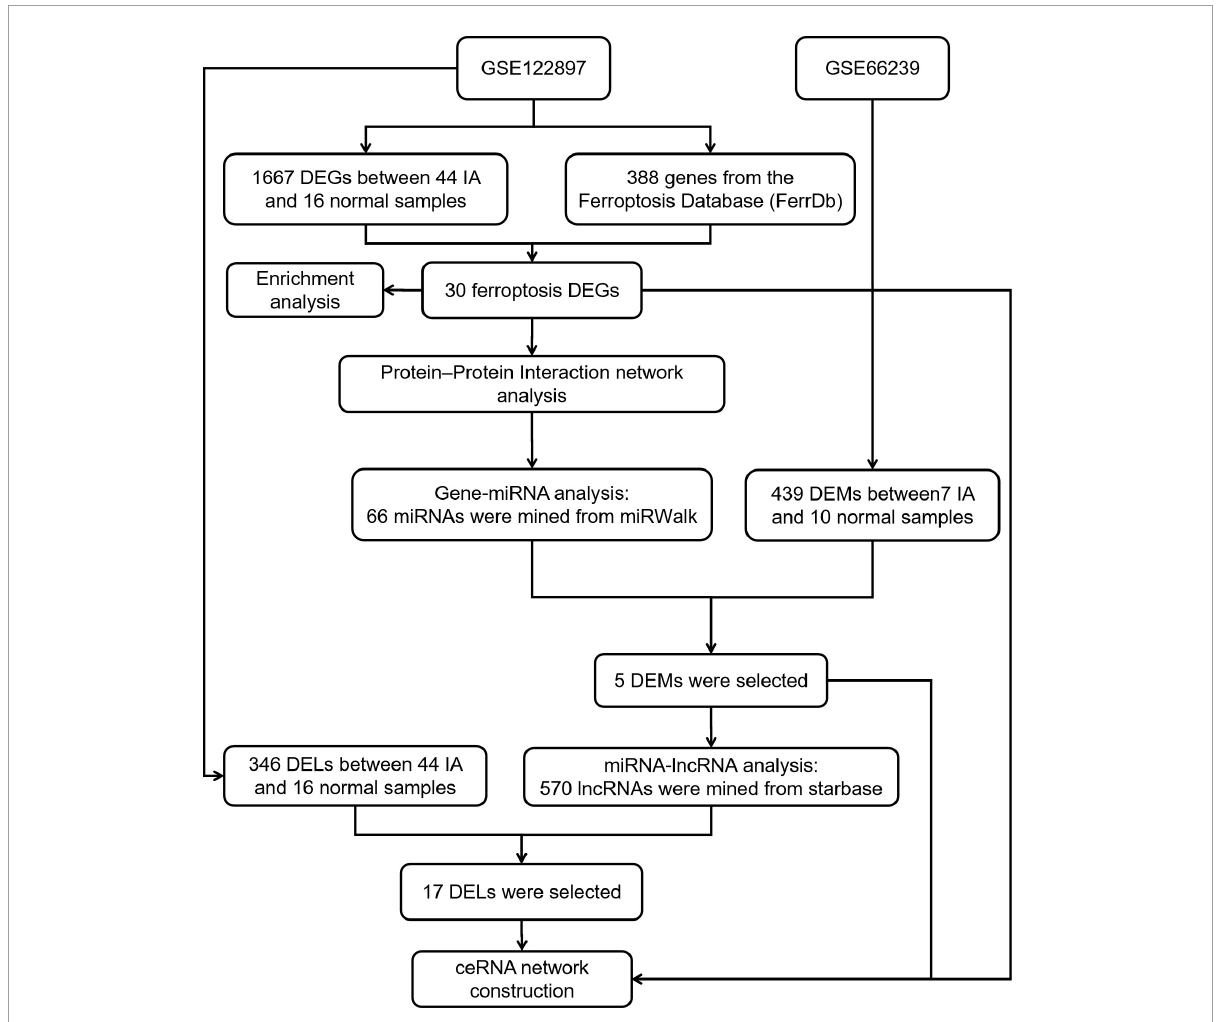
FIGURE1 A flowchart showing how the lncRNA–miRNA–mRNA regulatory network of an intracranial aneurysm (IA) was